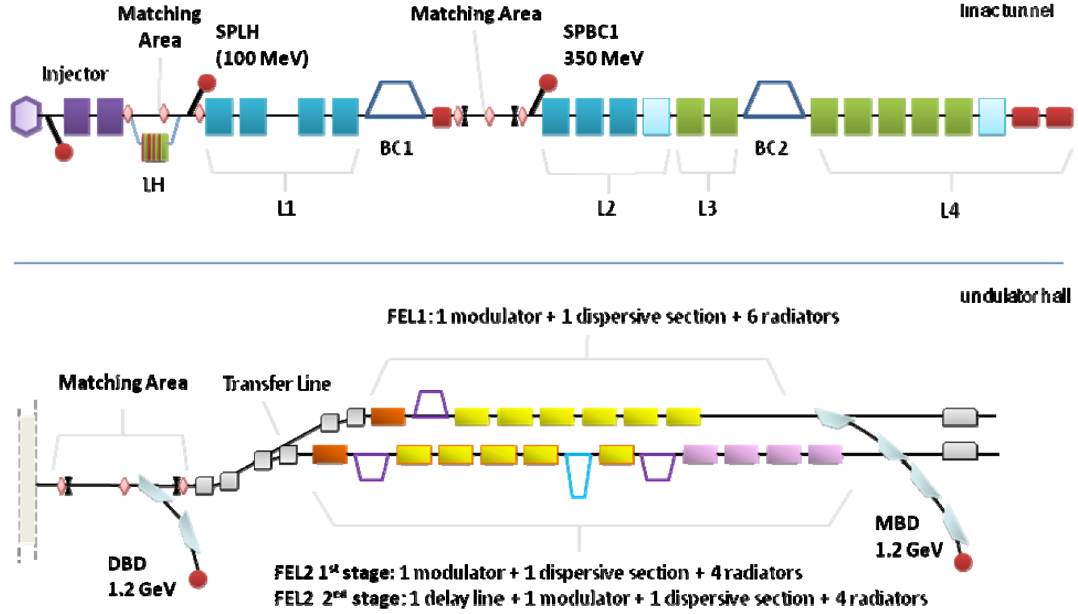
FIG. 1. Split layout of the Fermi FEL (conceptual, not to scale). The linac includes the injector, the laser heater (LH) area, different types of accelerating structures—represented with different colors—accommodated in linac 1 (L1), linac 2 (L2), linac 3 (L3), and linac 4 (L4), two magnetic chicanes for bunch length compression (BC1 and BC2), three optics matching area, the laser heater spectrometer line (SPLH), the first compressor spectrometer line (SPBC1), and the diagnostic beam dump (DBD). A transfer line brings the electron beam to the FEL1 or FEL2 undulator line (different undulator segments are represented by different colors), followed by the main beam dump (MBD) line.